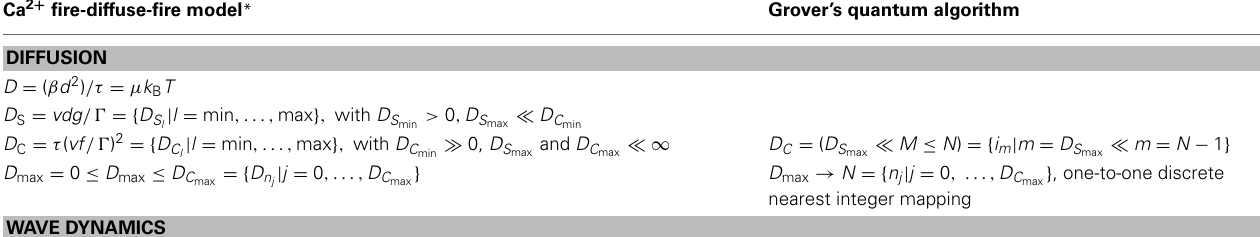
Table 1 | Comparison of major Ca 2 + fire-diffuse-fire model and Grover’s quantum algorithm parameters. Ca 2 + fire-diffuse-fire model * Grover’s quantum algorithm